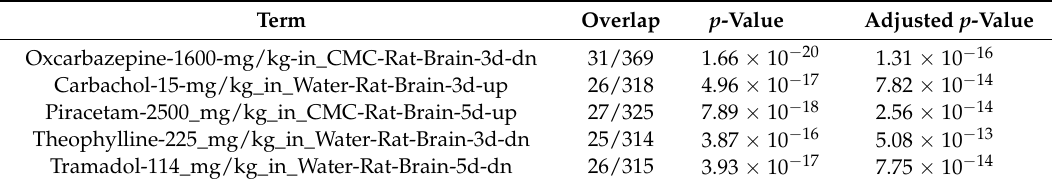
Table 8. Top ranked five gene expression profiles in drug matrix whose altered genes are associated with 244 gene symbols.